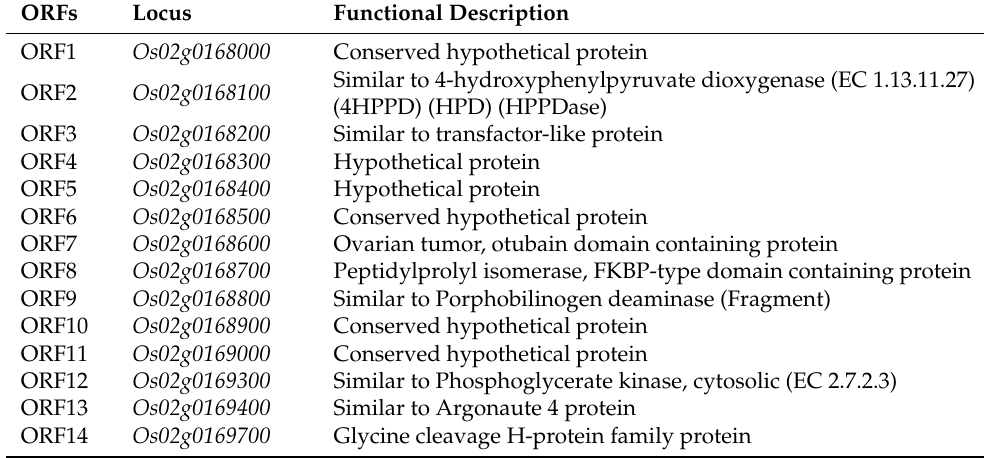
Table A3. The putative function of fourteen different genes in 123 kb mapping